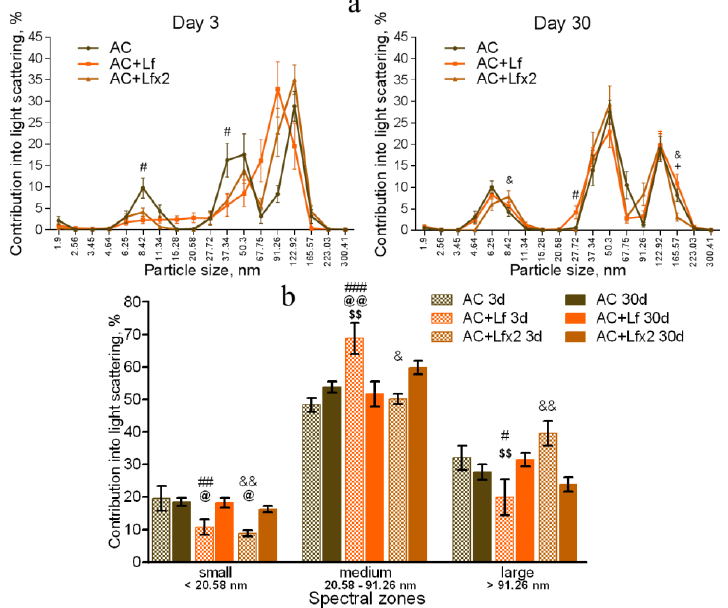
Figure 8. Changes in the DLS spectra of the blood serum from mice in the control groups on days 3 and 30 after sham-irradiation. n = 5–6 (day 3), n = 12–14 (day 30) for each group. Particle size distribution ( a ). # p < 0.05—AC+Lf vs. AC, & p < 0.05—AC+Lf×2 vs. AC, + p < 0.05—AC+Lf vs. AC+Lf×2. Particle distribution by spectral zones ( b ). # p < 0.05, ## p < 0.01, ### p < 0.001, & p < 0.05, && p < 0.01 in comparison with the same group on day 30; @ p < 0.05, @@ p < 0.01 in comparison with the AC group